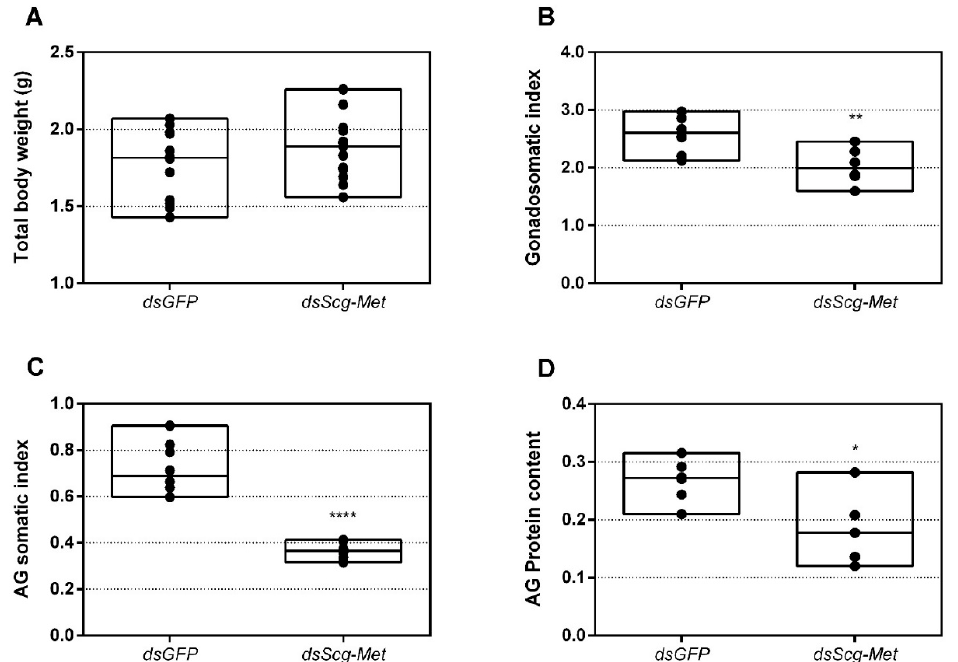
Figure 5. ( A ) Total body weight in grams of dsGFP and dsScg-Met injected adult male desert locusts 34 days after the adult molt. No significant differences (Student’s T-test) in body weight were observed between both conditions (the statistical p-value obtained for total body weight was 0.2414). For each condition 12 animals were analyzed. ( B ) Gonadosomatic index (GSI) of dsGFP and dsScg-Met injected adult male desert locusts 34 days after the adult molt. The GSI was significantly lower in dsScg-Met locusts compared to control animals. This result indicates the impaired development of the testes upon silencing of Scg -Met. Significant differences (Student’s T-test) are indicated with asterisks (** p < 0.01) (the statistical p-value obtained for GSI was 0.0014). For each condition 8 animals were analyzed. ( C ) Accessory gland somatic index (AGSI) of dsGFP and dsScg-Met injected adult male desert locusts 34 days after the adult molt. The AGSI was significantly lower in dsScg-Met injected locusts compared to dsGFP (control) animals. This result indicates the impaired development of the accessory glands (AG) upon silencing of Scg -Met. Significant differences (Student’s T-test) are indicated with asterisks (**** p < 0.0001). For each condition 8 animals were analyzed. ( D ) Normalized protein content of the accessory glands of dsGFP and dsScg-Met injected adult male desert locusts 34 days after the adult molt. The protein content of the AG was determined using the bicinchoninic acid assay (BCA) method and normalized to the respective AG weight. The relative protein content in the AG of dsScg-Met injected animals was significantly reduced compared to that of dsGFP injected (control) locusts. Significant differences (Student’s T-test) are indicated with asterisks (* p < 0.05) (the statistical p-value obtained for relative protein content in AG was 0.0255). For each condition 6 animals were analyzed. For all graphs, data points are represented in a column graph as a floating bar (min to max value) with a line indicating the median. (Abbreviations: ds = double stranded, Scg = Schistocerca gregaria , GFP = Green Fluorescent Protein, Met = Methoprene-tolerant).